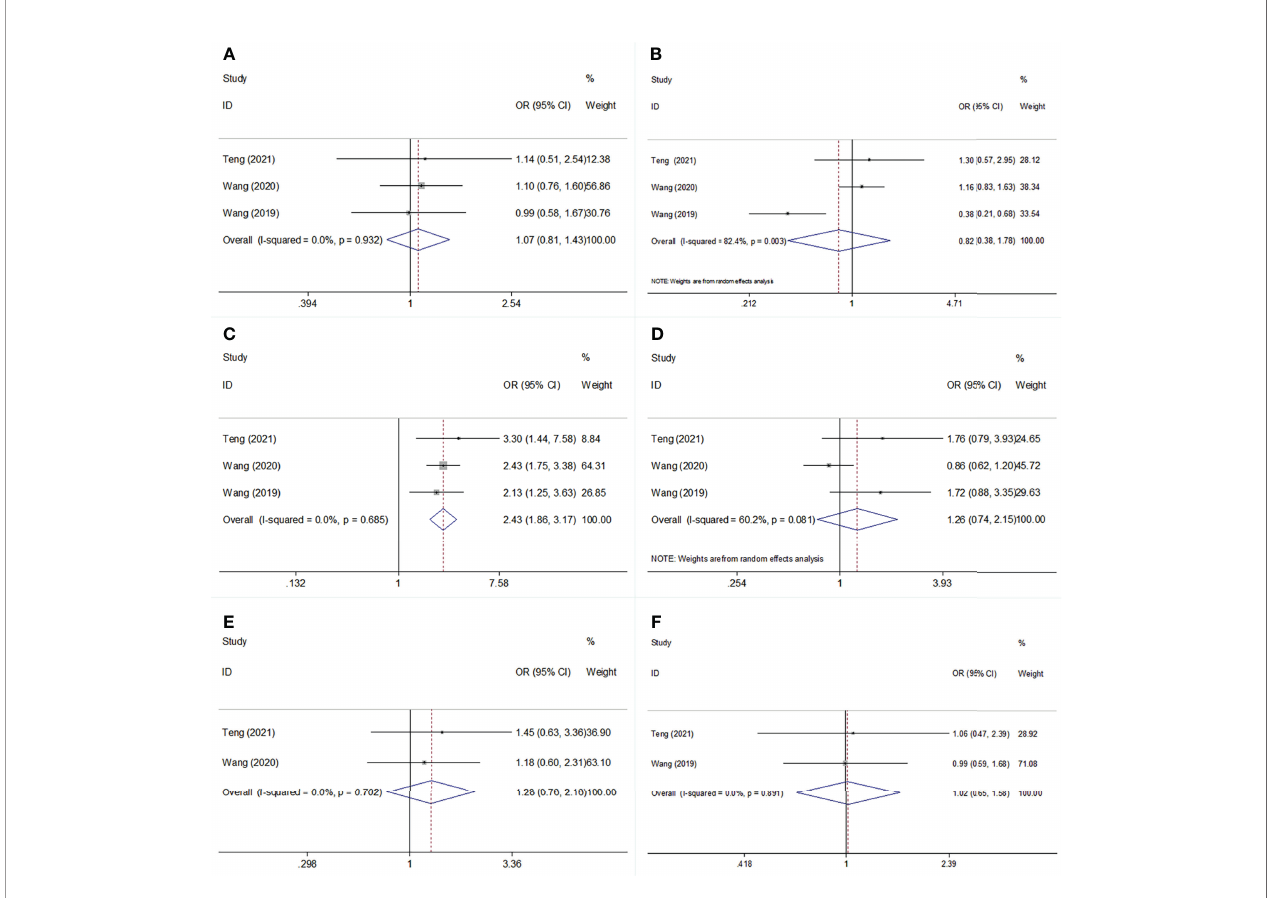
FIGURE 4 | Forest plot for the association of SII with age, sex, stage, smoking status, KPS score, and Initial therapeutic response in SCLC. (A) age; (B) sex: (C) stage: (D) smoking status; (E) KPS score; (F) Initial therapeutic response.